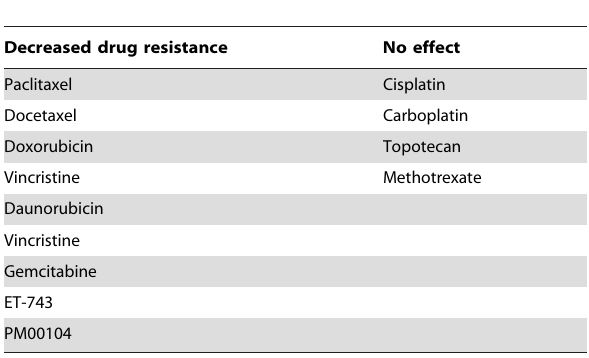
Table 2. Reverse Drug Resistance by NSC23925